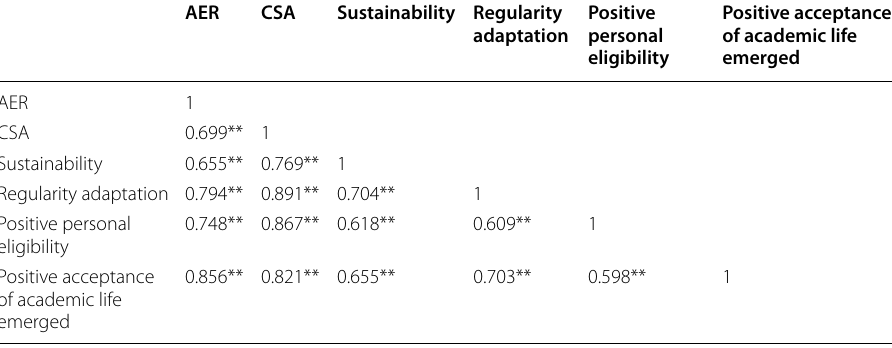
** Correlation is significant at the 0.01 level (2